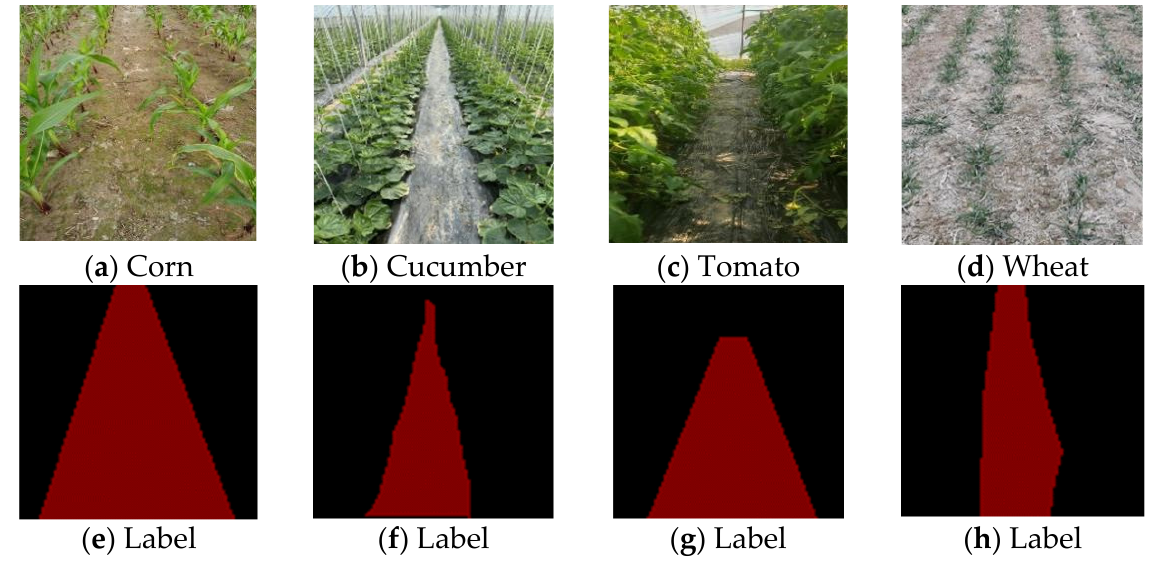
Figure 3. Different crop datasets and labeling results.